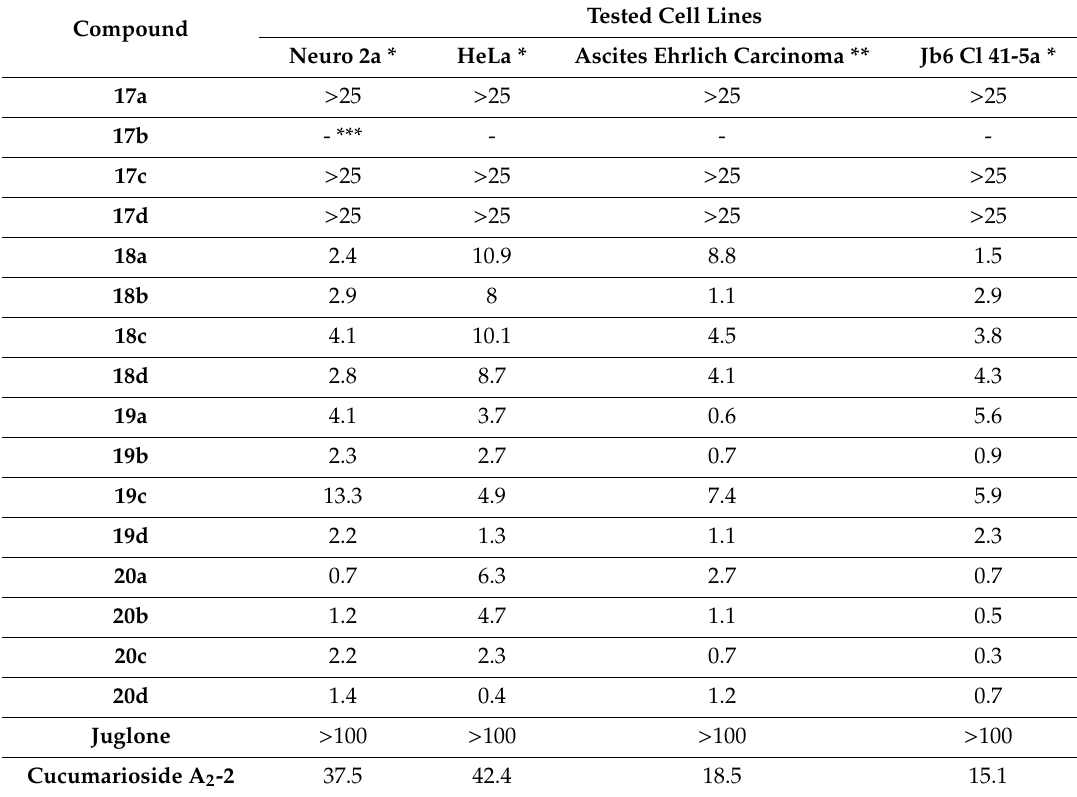
Table 1. Cytotoxicity (EC 50 ) of oxathiine fused 1,4-naphthoquinone tetracycles on cancer and non-cancer cell lines ( µ M). Compound